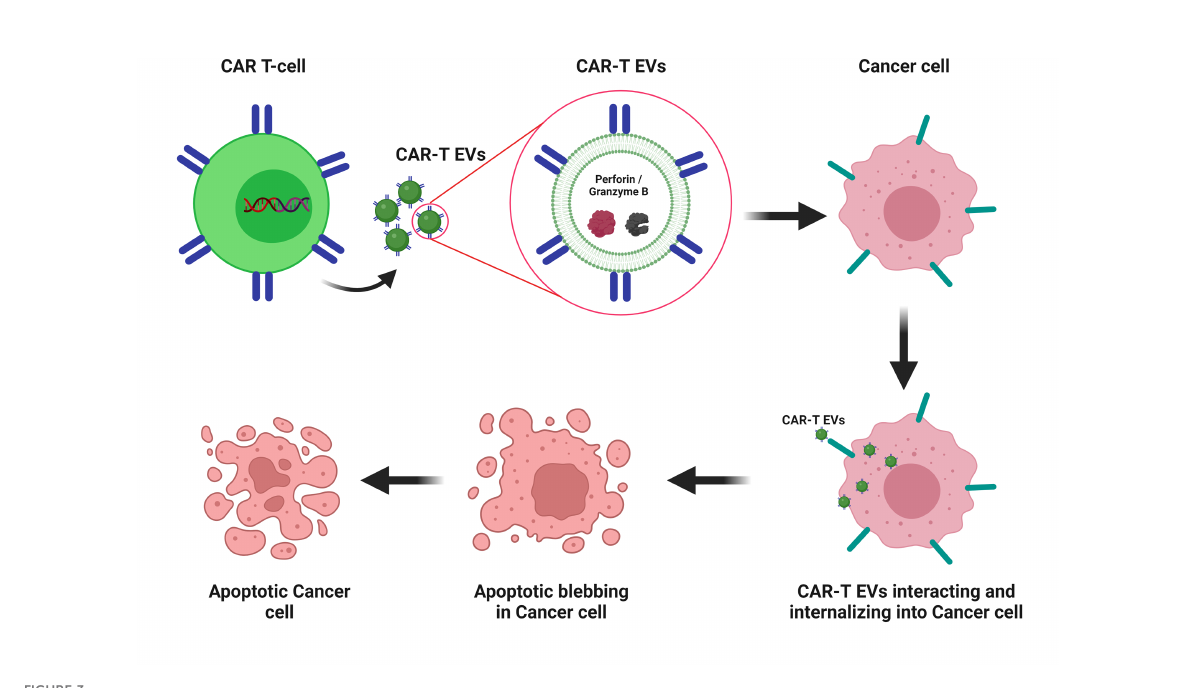
FIGURE 3 CAR-T EV-based therapy for cancer CAR-T EVs containing catalytic proteins (perforin and granzyme B). CAR-T EVs ’ interacting and internalizing into cancer cells and leading to apoptotic blebbing and apoptosis. Created with